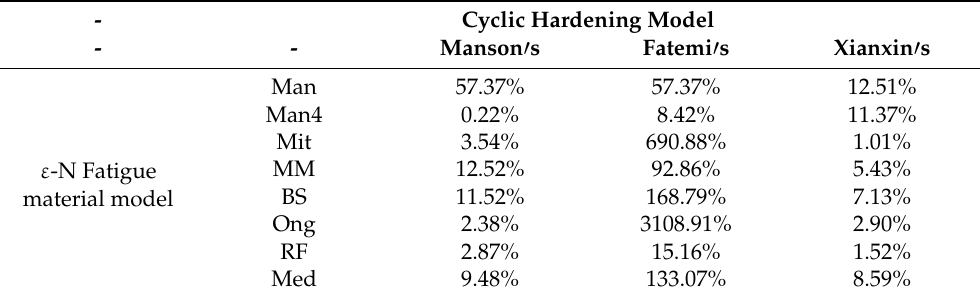
Table 6. The results of the numerical fatigue analysis related to the actual blade life (geometrical V-shape notch, resonance A = 1.8 mm), determined experimentally N in = 12.9 × 10 3 )